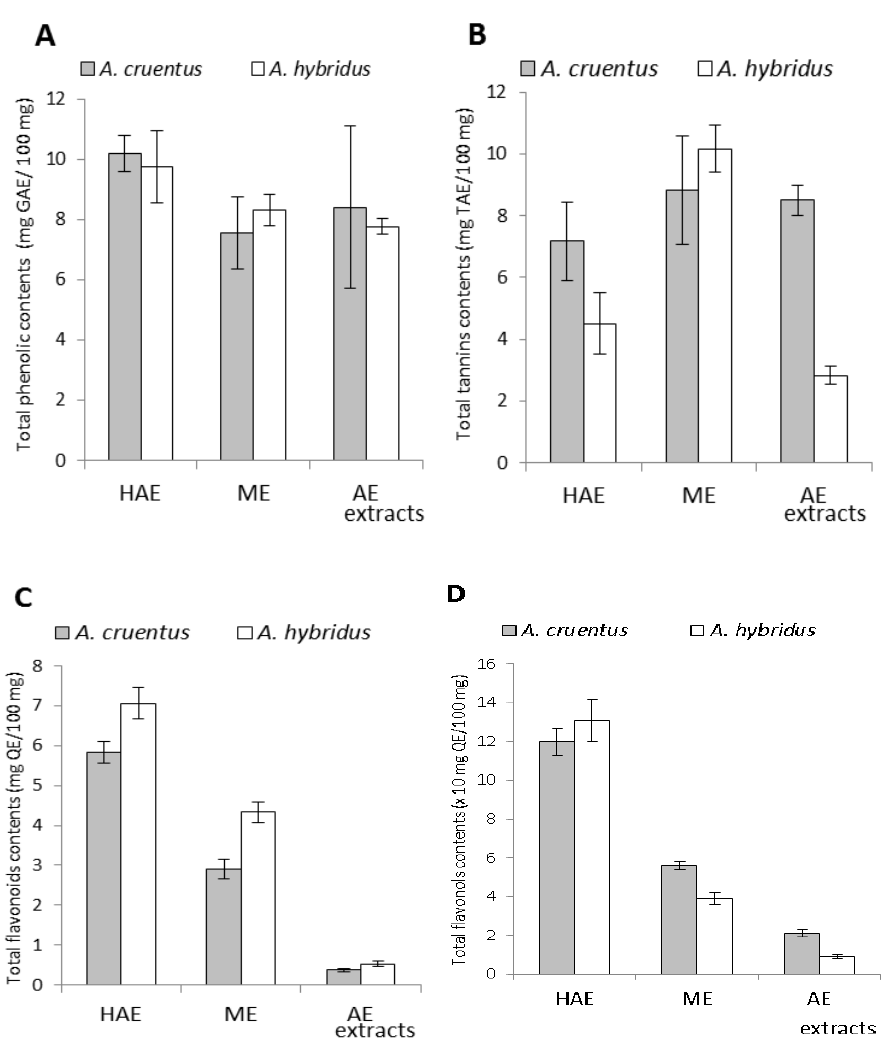
Figure 2. Polyphenols, tannins, flavonoids and flavonols